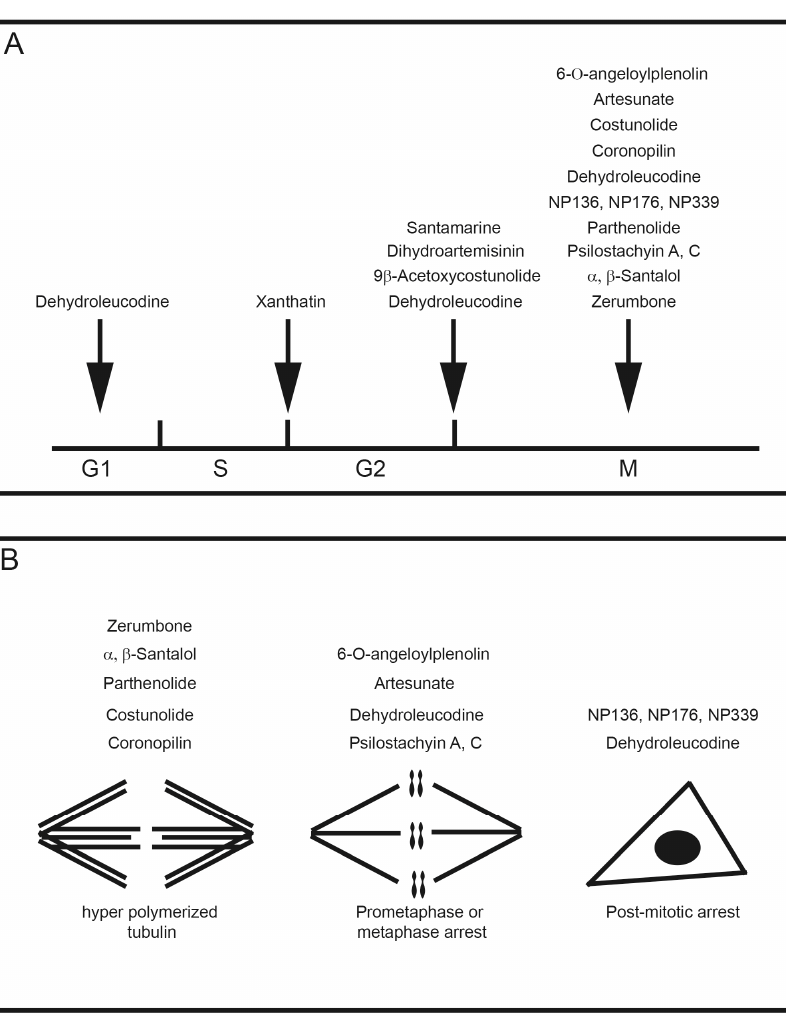
Figure 2. ( A ) The position of the cell cycle arrest relative to the phases of the cell cycle are given for the compounds. ( B ) The types of mitotic and post mitotic arrests are given for the compounds.